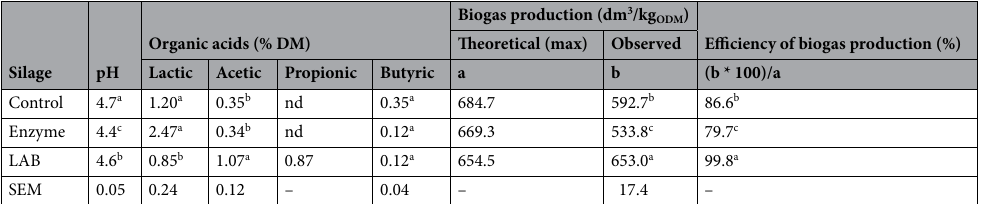
Table 3. Organic acids in the silages and production of biogas from Spartina pectinata L. LAB Lactobacillus buchneri M B/00077, SEM standard error of the mean. a–c Mean values (in columns) marked with different letters differ significantly, α =